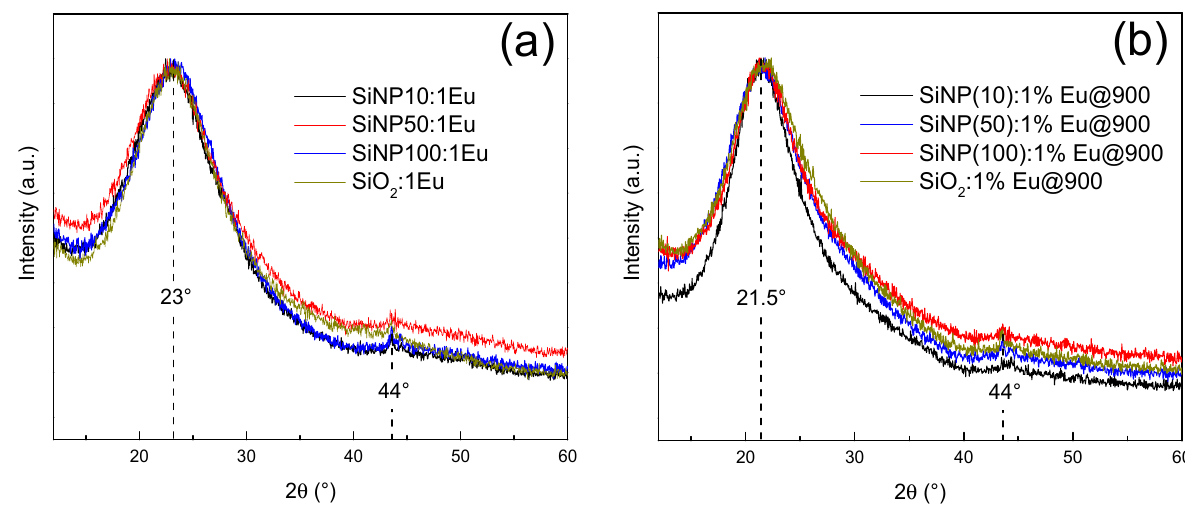
Figure 3. XRD patterns of SiNPX:1Eu and of bulk SiO 2 :1Eu : ( a ) before thermal treatment; and ( b ) after thermal treatment.